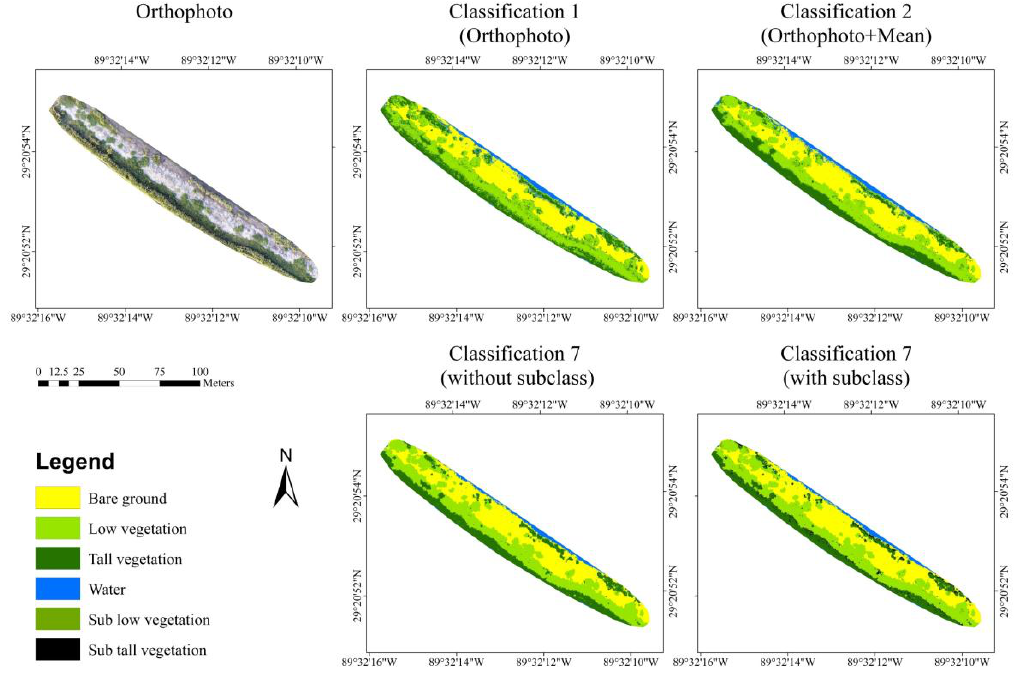
Figure 7. The comparative results of selected classifications. Table 1. Comparison of classification accuracies based on different input layers and support vector machine classifier.